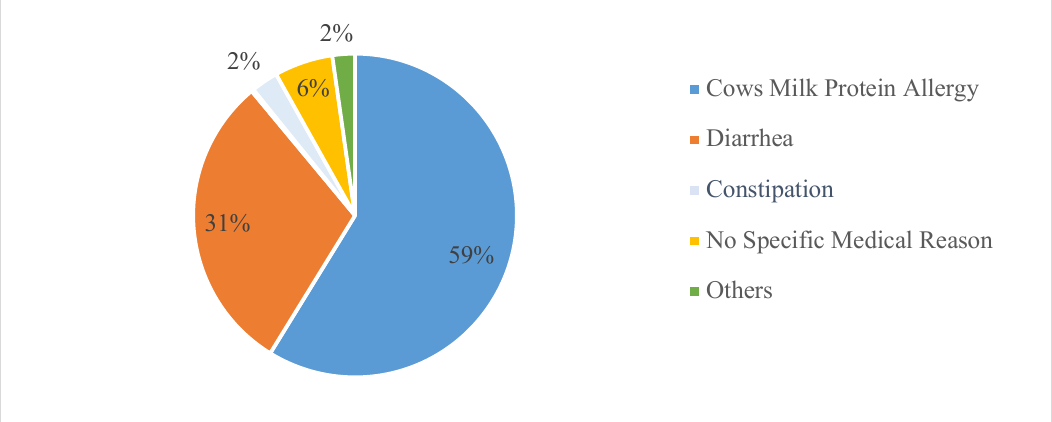
Figure 1. Reason to not consume cow’s milk reported from patients during